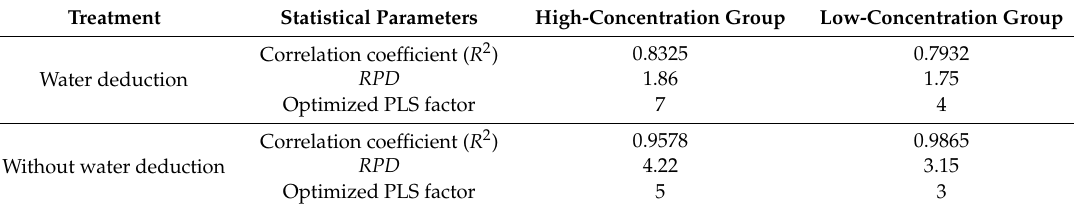
Figure 4. Distribution and model evaluation of the partial least squares (PLS) factor ( a , d ), training set (( b , e ); n = 33), and testing set (( c , f ); n = 11) of the partial least squares regression (PLSR) prediction model (without water deduction) for high nitrate solutions ( a – c ) and low nitrate solutions ( d – f ). Note: RMSECV , root mean square error in cross validation; RMSEC , root mean square error of calibration; RMSEP , root mean square error of prediction. Table 1. Number of optimal PLS factors and model evaluation results of the PLSR model with and without water